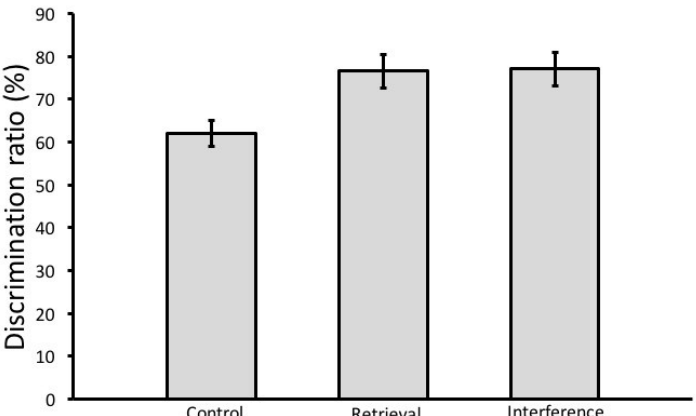
Figure 5. Discrimination ratio in the test phase (kindling group). The discrimination ratio was calculated by dividing the total amount of exploration of the novel object by the total amount of object exploration. No significant difference was found between the three groups. Mean ± SEM is